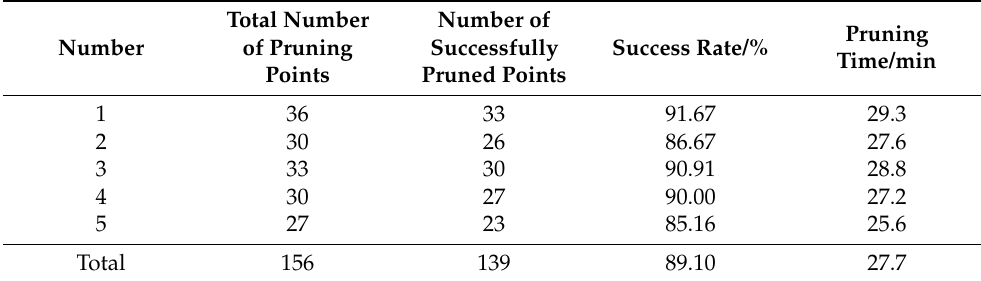
Table 4. The results of the pruning